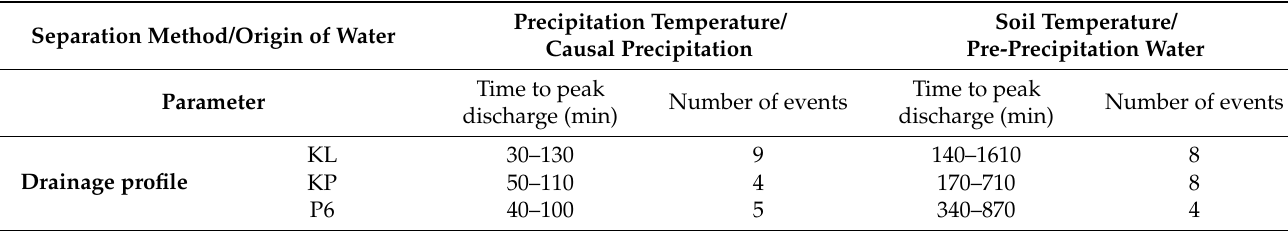
Table 5. Time to peak discharge (min) and number of events according to used separation method and origin of water.